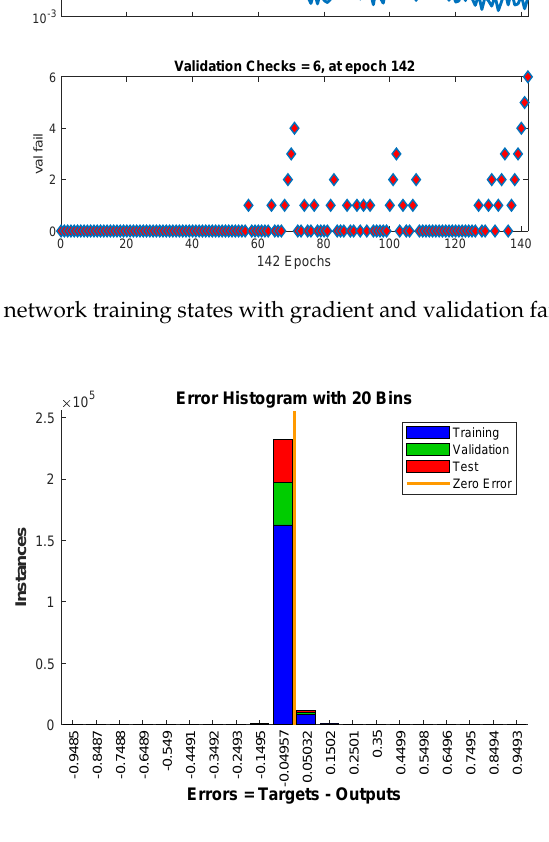
Figure 13. The error histogram of the trained neural network for the training, validation and testing phases.